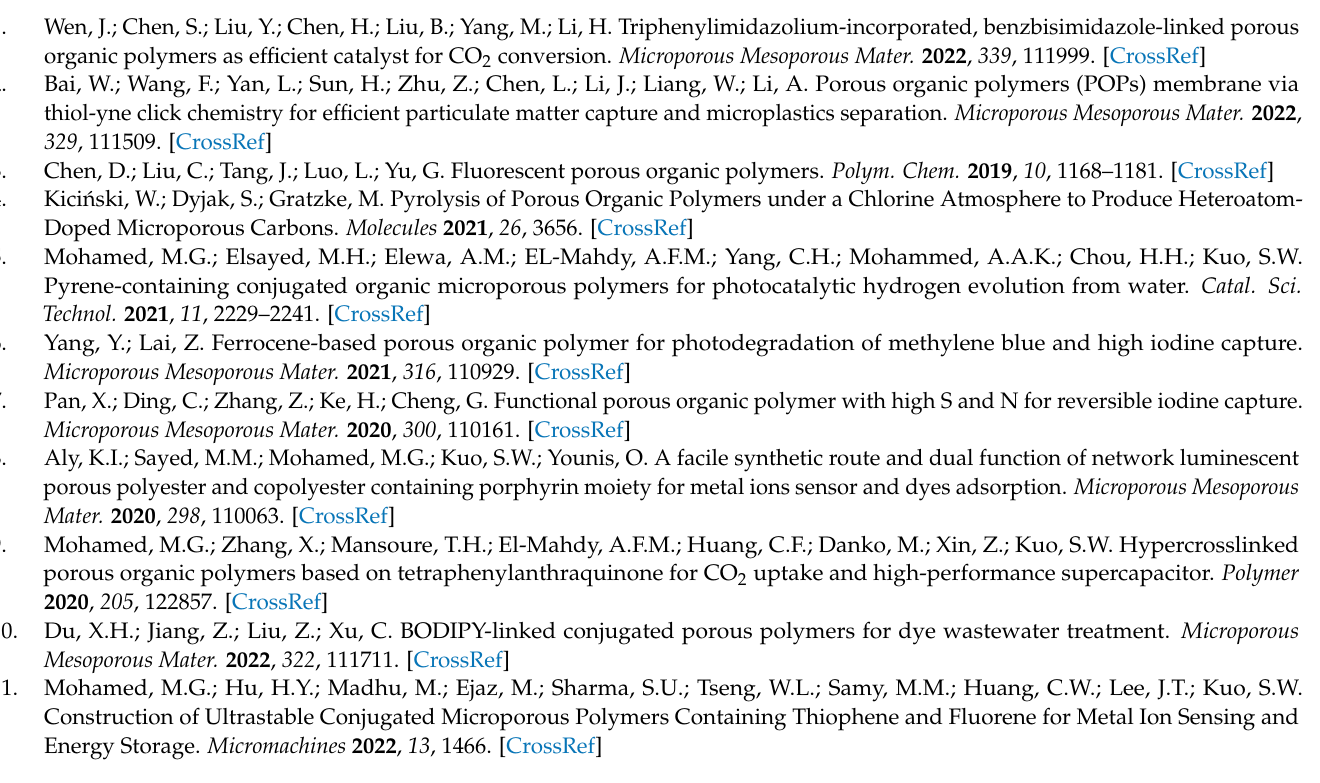
TPTh POIP. Figure S15. Cyclic voltammetry curves (a–c) and (d–f) galvanostatic charge-discharge profiles of POSS-OXD, POSS-Th and POSS-TPTh POIPs. Figure S16. Nyquist plots of POSS-Th, POSS-TPTh, and POSS-OXD